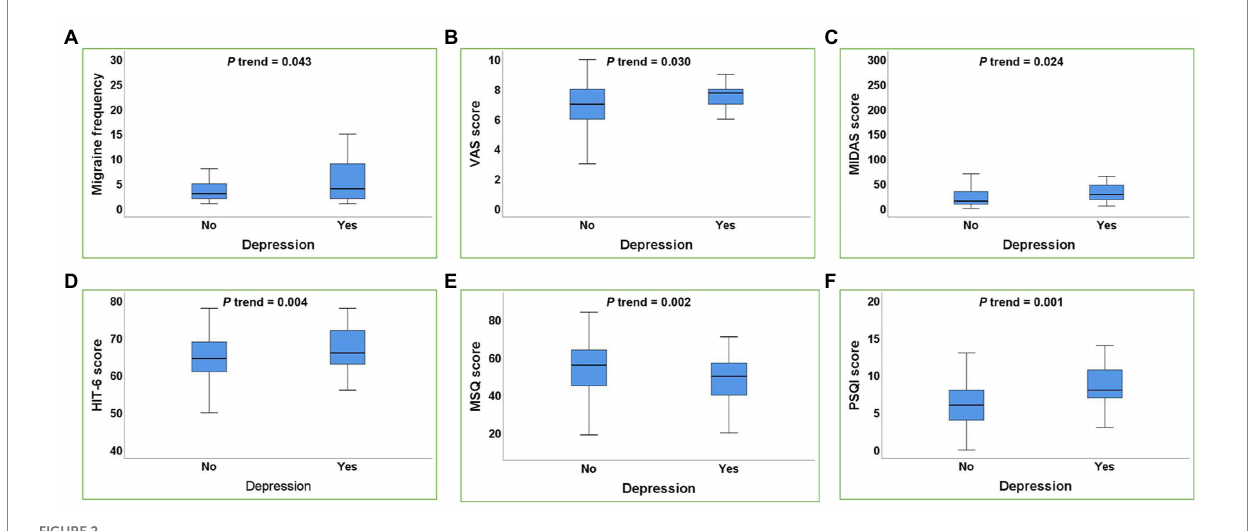
FIGURE 2 Box plot of the relationship between depression and migraine-related burdens. (A–F) : Depression was positively correlated with the migraine frequency (A) , VAS score (B) , MIDAS score (C) , HIT-6 score (D) , PSQI score (F) and negatively correlated with MSQ score (E) in migraine patients (all p trend<0.05). p trend value: Adjusted for age, gender, smoking history, drinking history, BMI, weekly exercise time, pressure score, migraine aura.